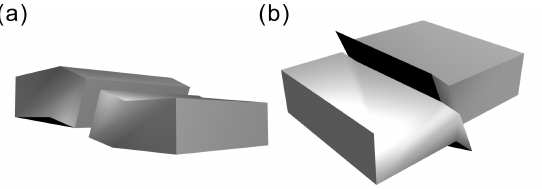
Figure 7. Demonstration of oblique-slip fault drag. ( a ) Normal drag in sinistral-reverse fault. ( b ) Re- verse drag in sinistral-reverse